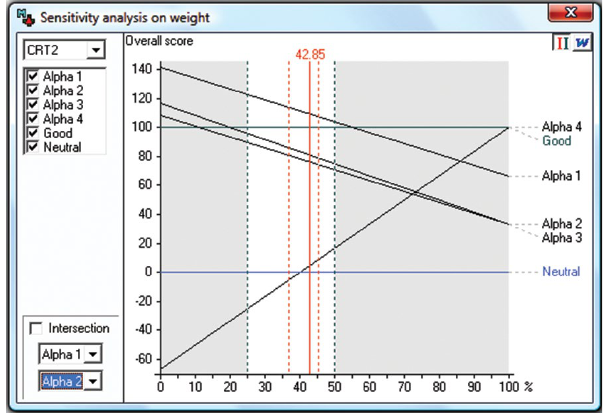
Fig. 9. Sensitivity analysis on CRT